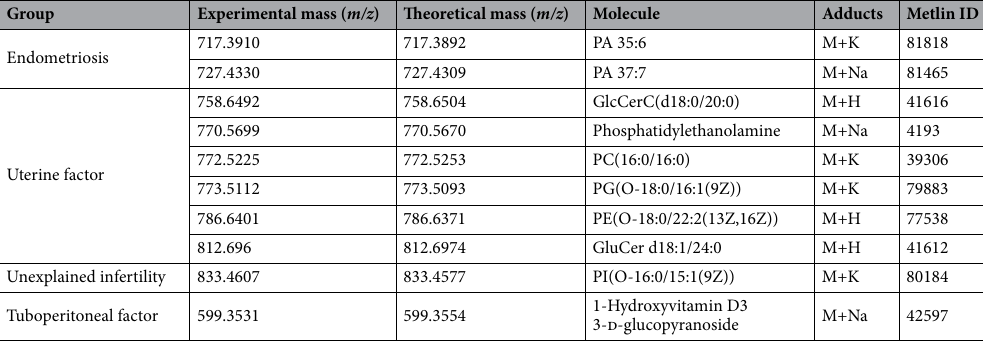
Table 1. Chemical markers elected by Ortho-PLS-DA VIP